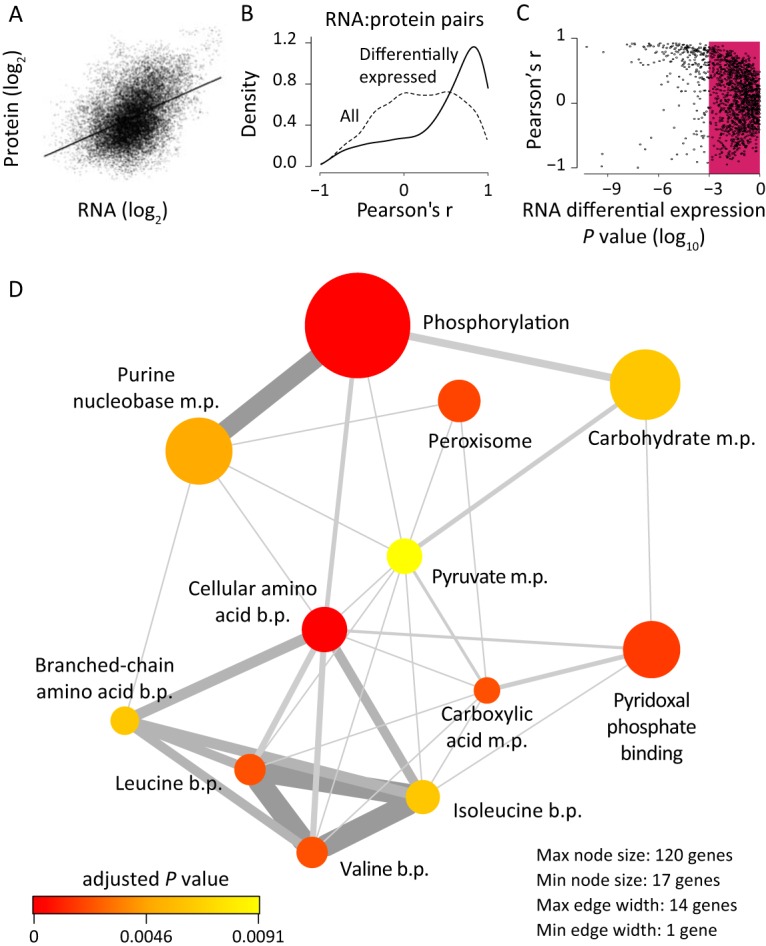
Correlation of log-normalized RNAseq read counts with log-normalized protein counts. (A) All measured RNA and protein counts combined in one comparison, with poor correlation observed. (B) Density plot of Pearson’s r for all RNA-protein pairs (dotted line) and for only those RNA-protein pairs that showed differential expression at the level of RNA (adjusted P < 0.01; solid line). (C) Representation of the correlations of both the genes that were not significantly changed (in red box) and the genes whose transcripts were found to have changed in comparisons of all chemostats (adjusted P < 0.01). (D) Network plot of enriched GO terms in the highly correlated gene pairs (P < 0.01). The size of the node represents the number of genes within the GO term. The node’s color represents the adjusted P value. The thickness of the edge indicates the number of genes overlapping two GO terms. m.p., metabolic process; b.p., biosynthetic process.